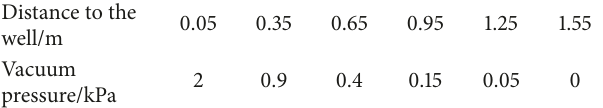
Figure 7: Water level in constant flow boundary